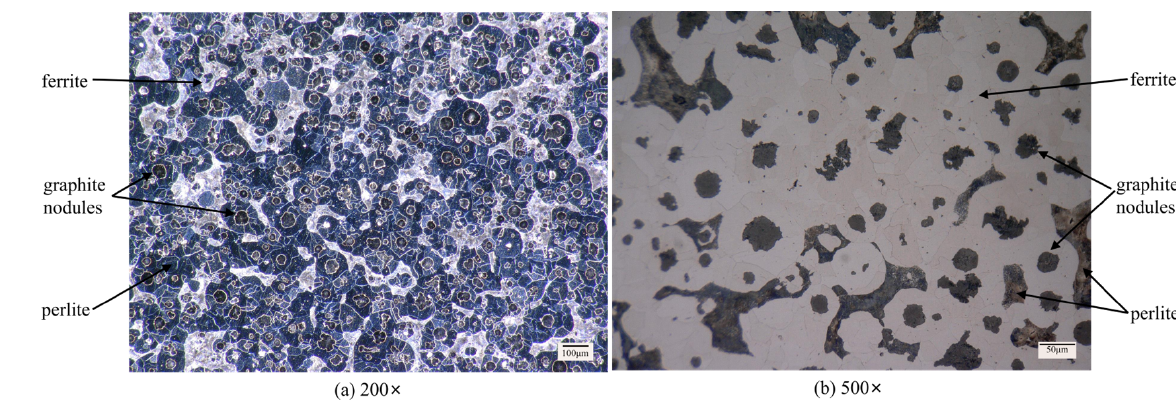
(2) the middle layer was an elastic material (Shore 30 silica gel), and (3) the lower layer was a diamond polishing sheet ( ϕ 29 mm). Figure 1. Microstructure of nodular cast iron QT700-2: ( a ) 200×, ( b ) 500×.